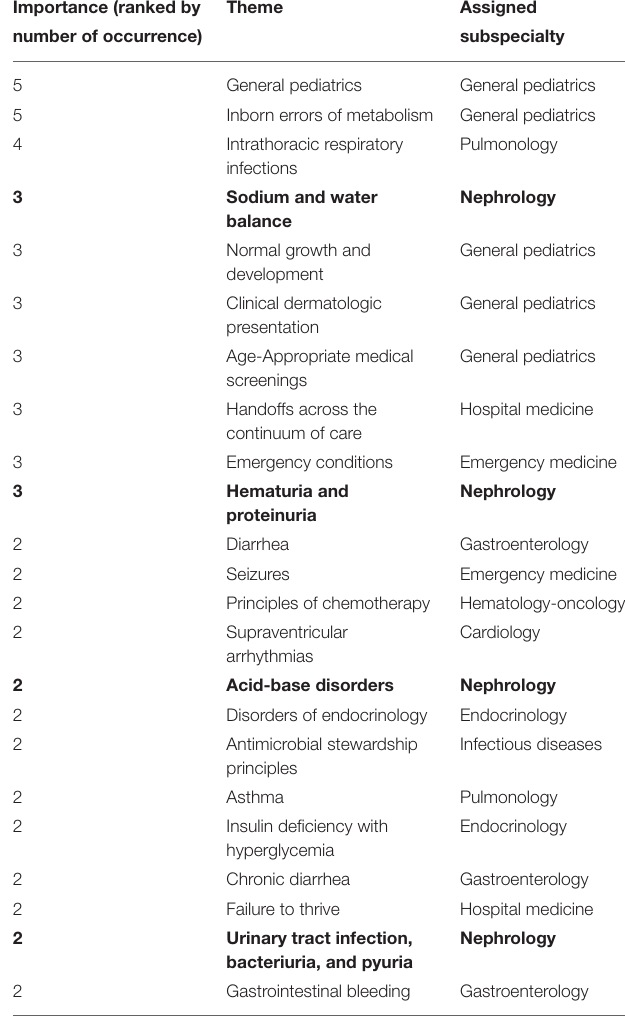
TABLE 2 | Practical skills (mentioned by at least four interviewees) drafted from the qualitative explorative interviews ( n = 16). Practical skills